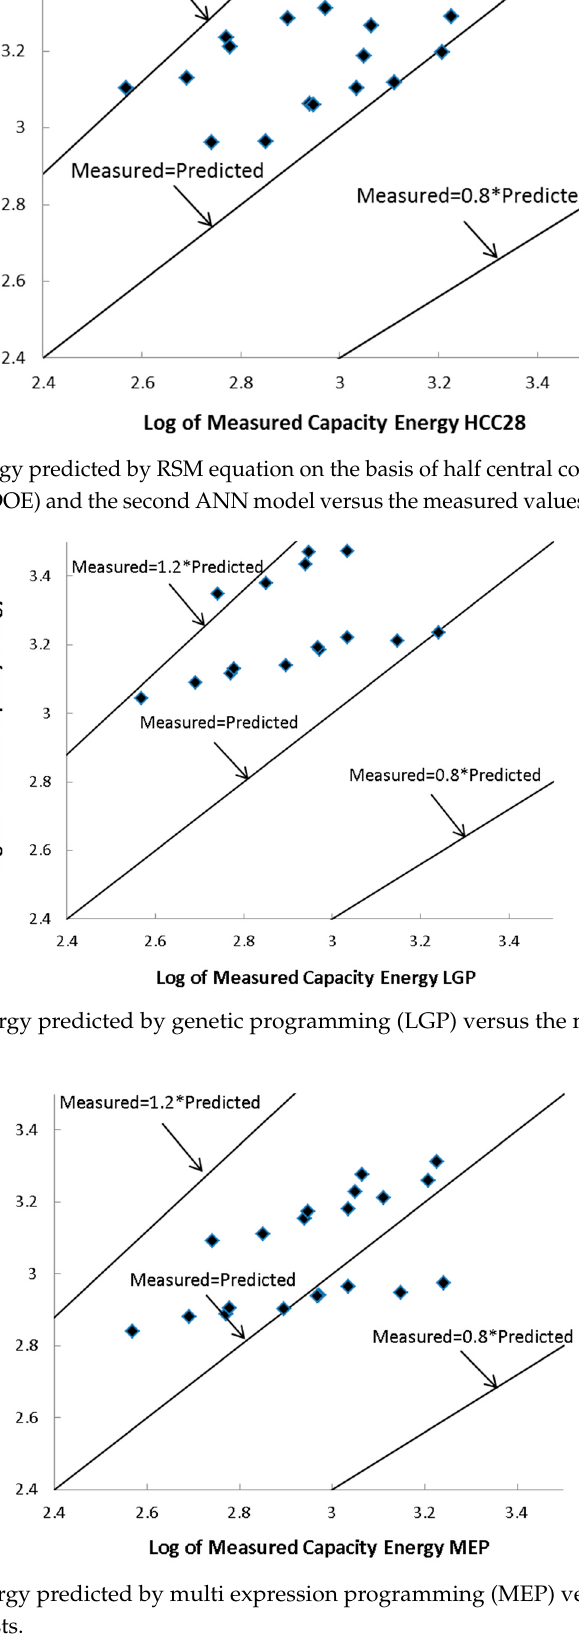
values of laboratory tests.